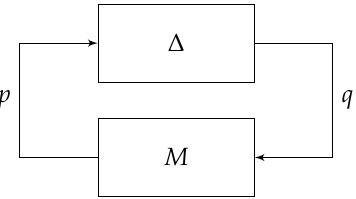
Figure 6. Equivalent M - ∆ structure with M = − T q → p ( G , C ) for robust stability